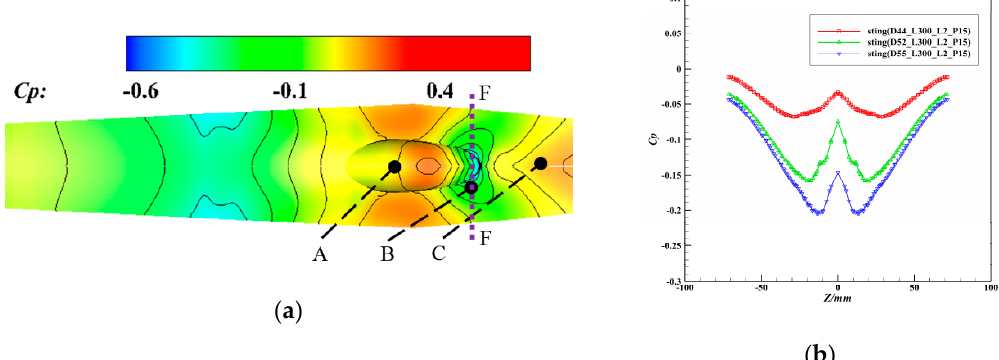
Figure 8. Pressure contour and distribution of the BWB aircraft with di ff erent straight-section diameters (D = 44 mm / 52 mm / 55 mm, Ma = 0.75, α = 0 ◦ ): ( a ) pressure contour of the BWB aircraft under the D = 55 mm condition; ( b ) pressure distribution of profile F-F (position of F-F is shown in Figure 8a).